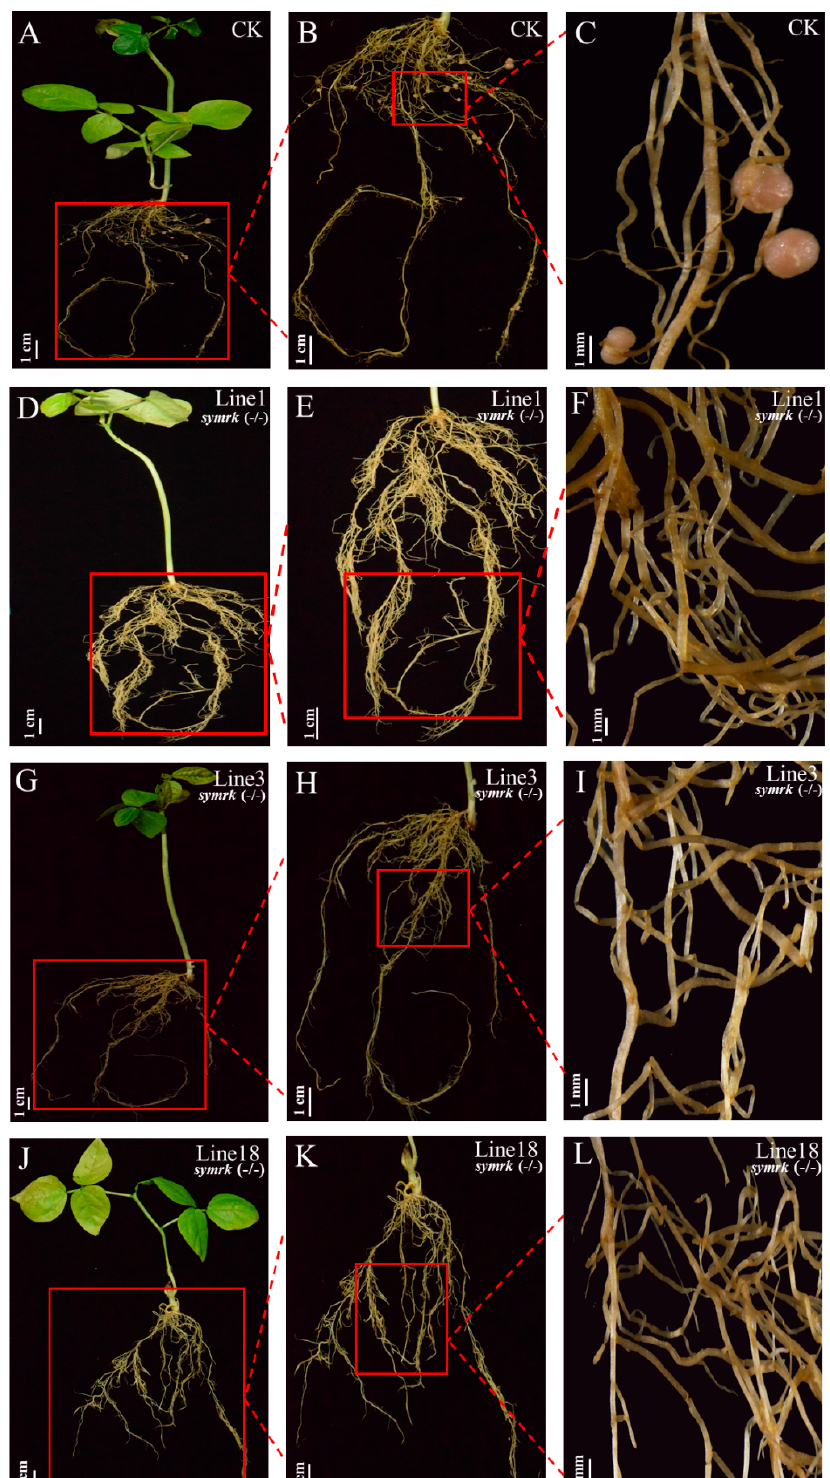
Figure 4. Symbiotic nodulation phenotype of cowpea SYMRK mutants. The transgenic hairy roots were inoculated with Sinorhizobium sp. NGR234. Pictures were taken after three weeks post inoculation (3 wpi). ( A – C ) Nodulation phenotype of hairy roots transformed with the empty vector (CK): ( A ) whole plant; ( B ) hairy roots; ( C ) enlarged hairy roots with nodules. ( D – L ) Nodulation phenotype of SYMRK mutant line 1 ( D – F ), line 3 ( G – I ) and line 18 ( J – L ).